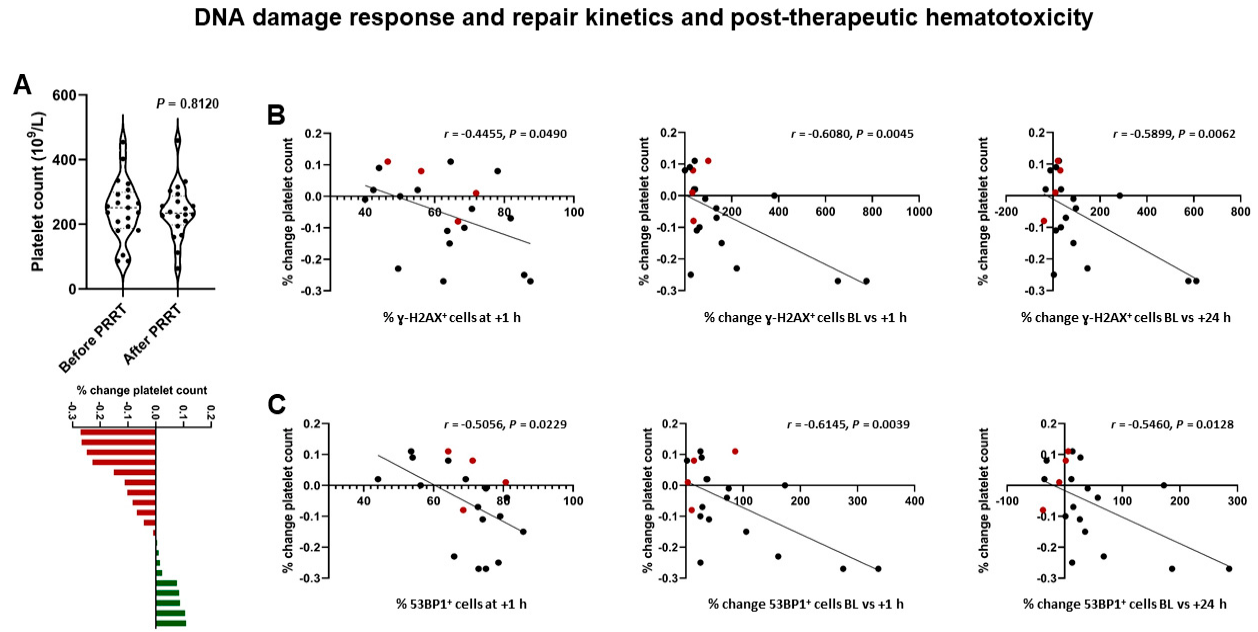
Figure 4. DNA damage response and post-therapeutic subclinical hematotoxicity in patients receiving PRRT. ( A ) Violin plot (upper panel) showing a decrease of − 5 ± 13% in platelet count following PRRT on a per-group basis. Waterfall plot (lower panel) showing individual changes in platelet counts, ranging from − 27 to +11%. ( B ) Results of correlation analysis. % change in platelet count following PRRT is significantly correlated with the relative number of γ -H2AX + cells at +1 h, and % change of γ -H2AX + cells between baseline and +1 h, and baseline and +24 h. ( C ) Likewise, % change in platelet count following PRRT is significantly correlated with the relative number of 53BP1 + cells at +1h, and % change of 53BP1 + cells between baseline and +1 h, and baseline and +24 h. Red dots indicate patients with increasing tumor burden. (Platelet count was available in 4/5 patients).